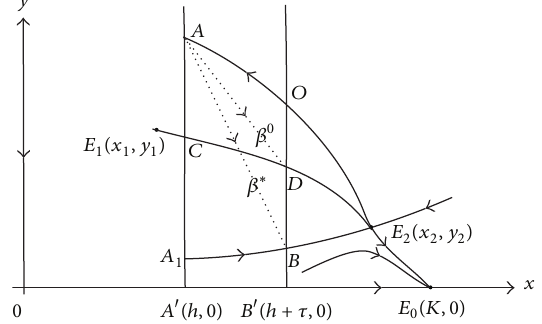
Figure 5: Illustration of homoclinic bifurcation of system (2) by choosing the harvesting rate 𝛽 as control